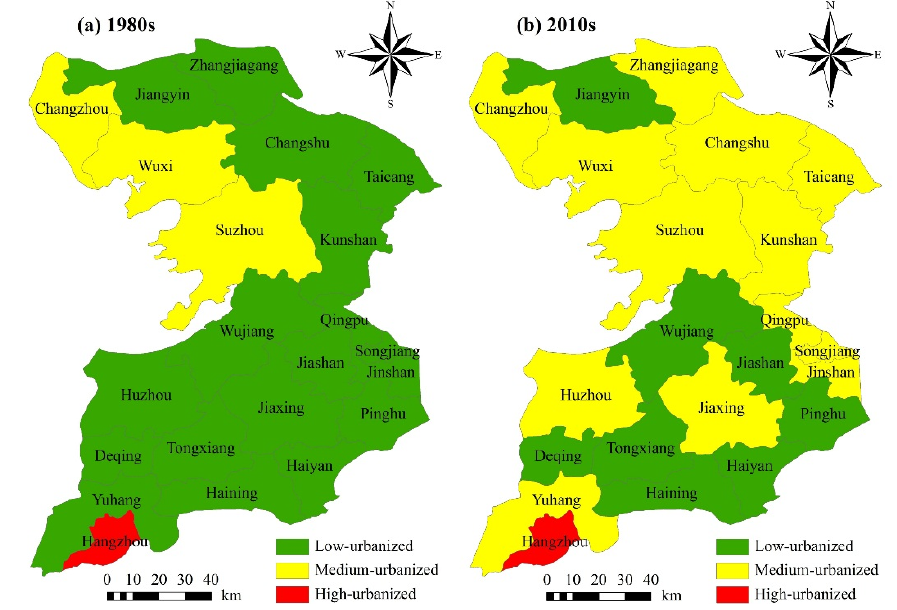
Figure 3. Different urbanization levels of 22 cities of the Taihu Region in the 1980s and 2010s.